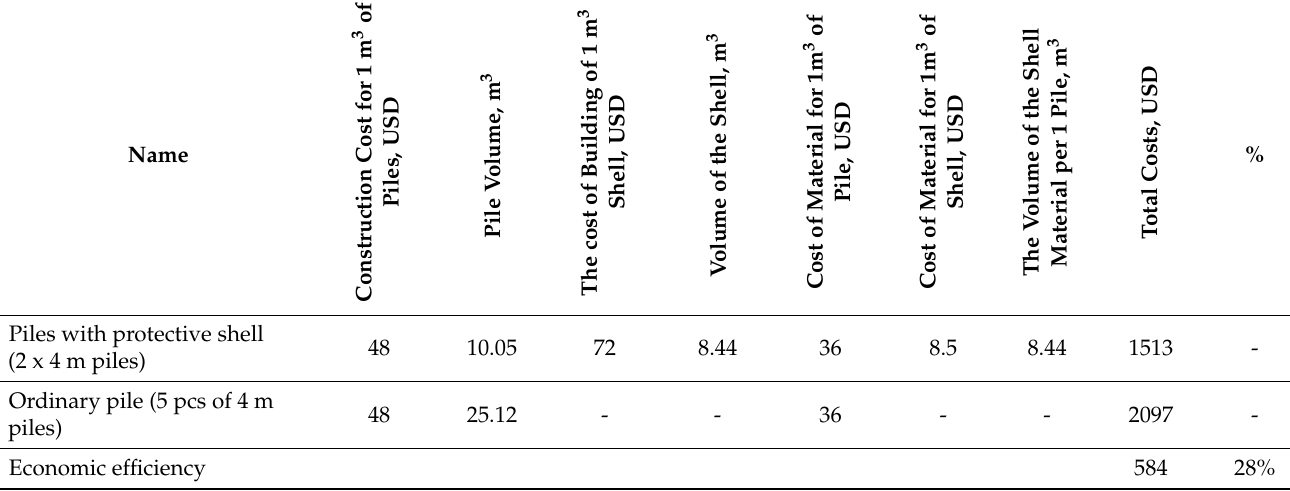
Table 6. Calculation of economic efficiency of piles with protective